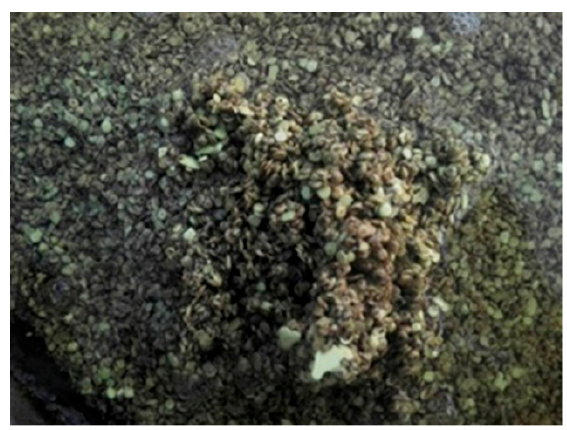
Figure 5. Sulfur particles with biofilm attached.